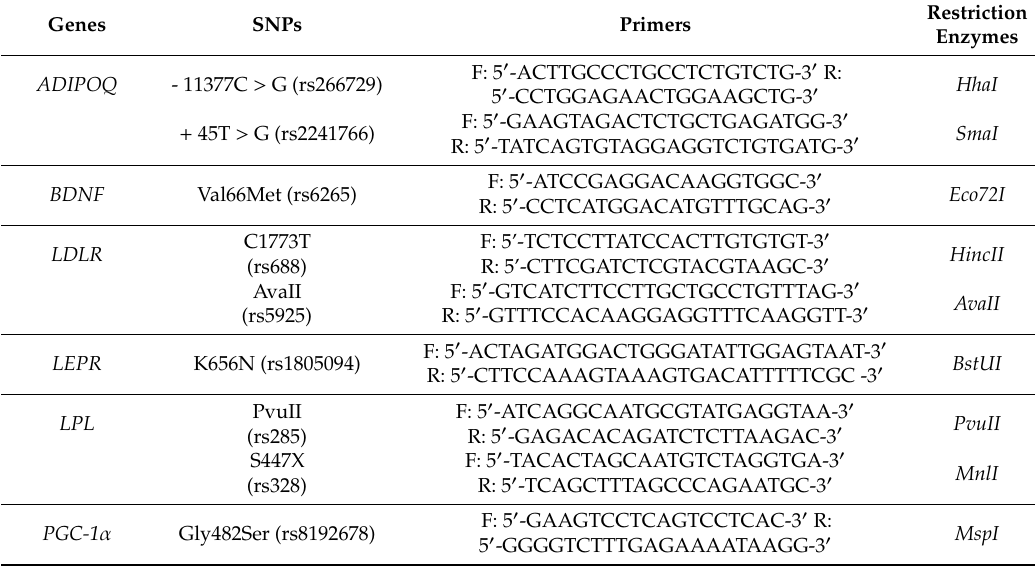
Table 1. Primers and restriction